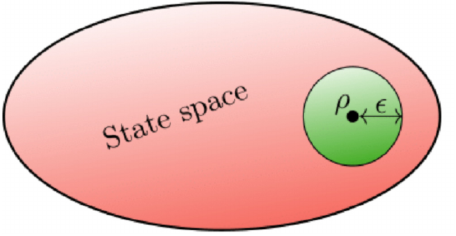
FIG. 2. The task of quantum-state certification is to detect when a state preparation ˜ ρ is not close to a chosen target state ρ , i.e., when dist (ρ , ˜ ρ) > (cid:2)